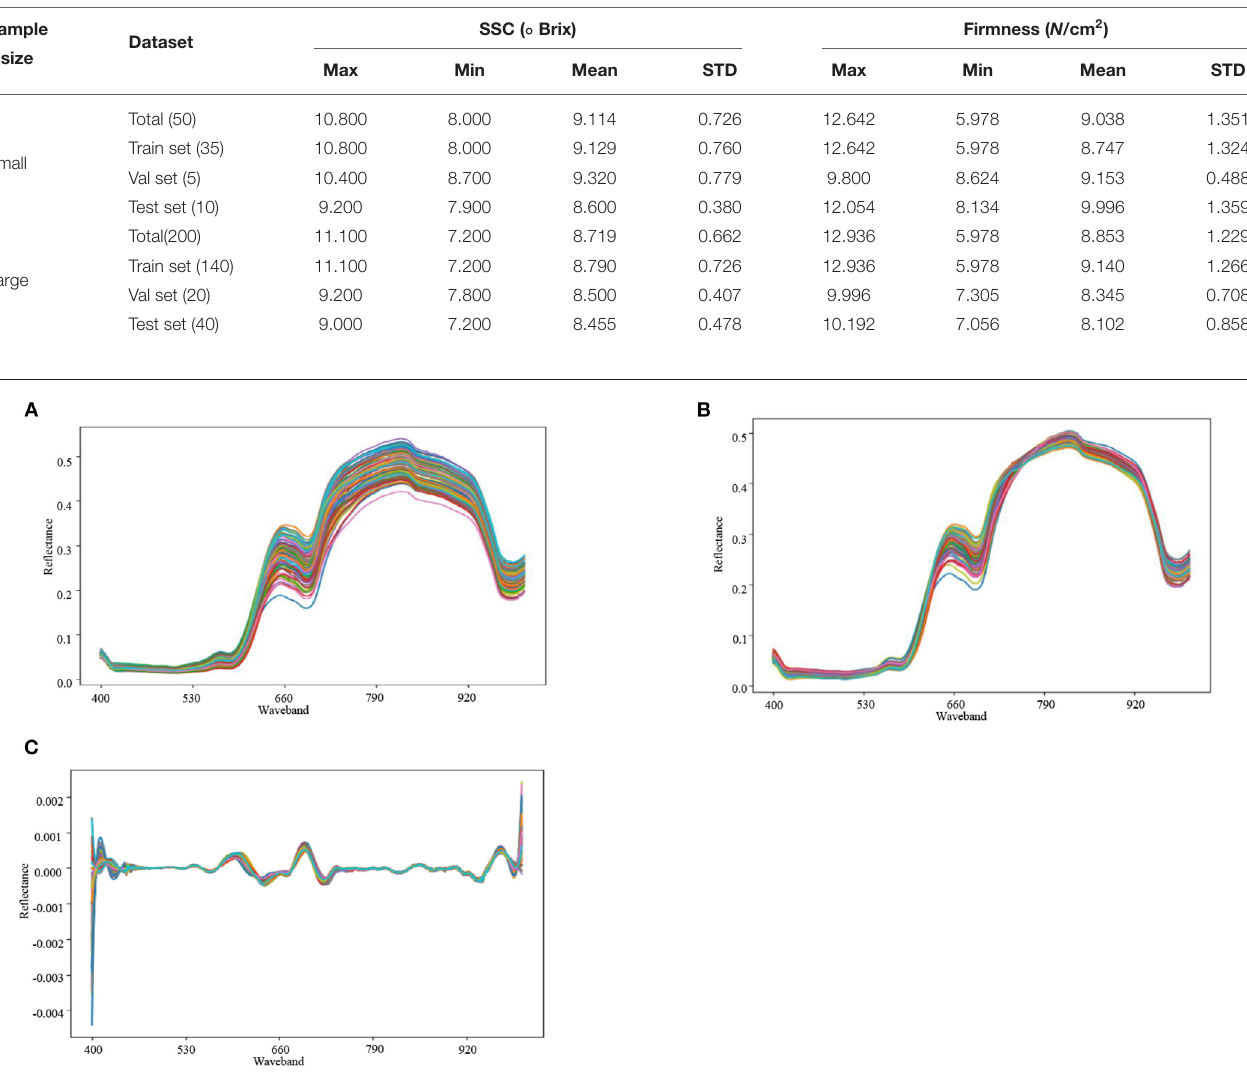
FIGURE 5 | (A) Corrected spectral reflectance map. (B) MSC preprocessing. (C) Second-order differential preprocessing.